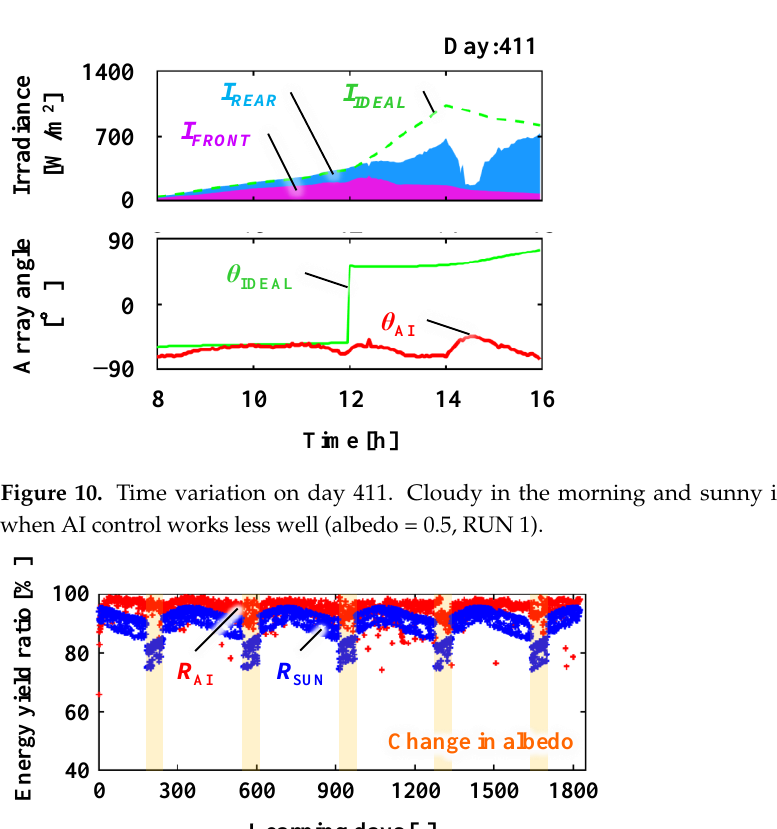
Figure 10. Time variation on day 411. Cloudy in the morning and sunny in the late afternoon, when